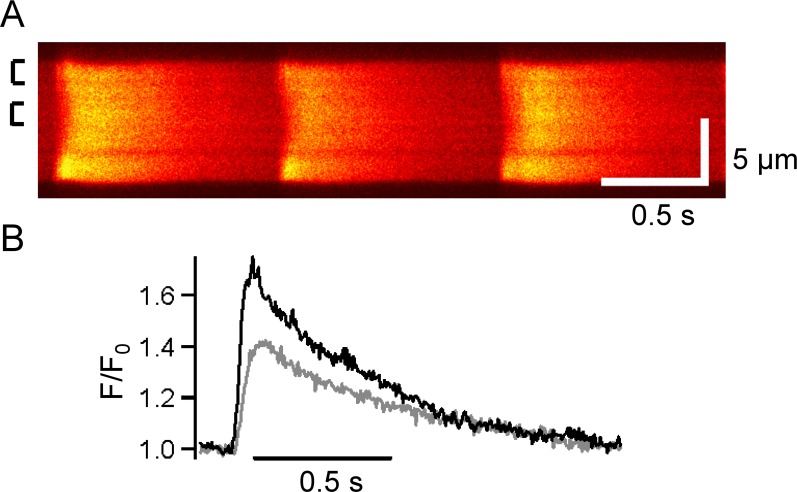
Spatiotemporal properties the atrial Ca2+ transient.A) Representative linescan of a fluo-4-loaded pig isolated atrial myocyte. Vertical scale represents 5 μm. Boxes on the left indicate regions averaged to produce traces shown in (B). B) Normalized fluorescence (F/F0) of averaged transients at the edge (black) and center (grey) of the cell. Global diastolic level between transients was used as F0. Data are representative of 4 cells from 2 pigs.